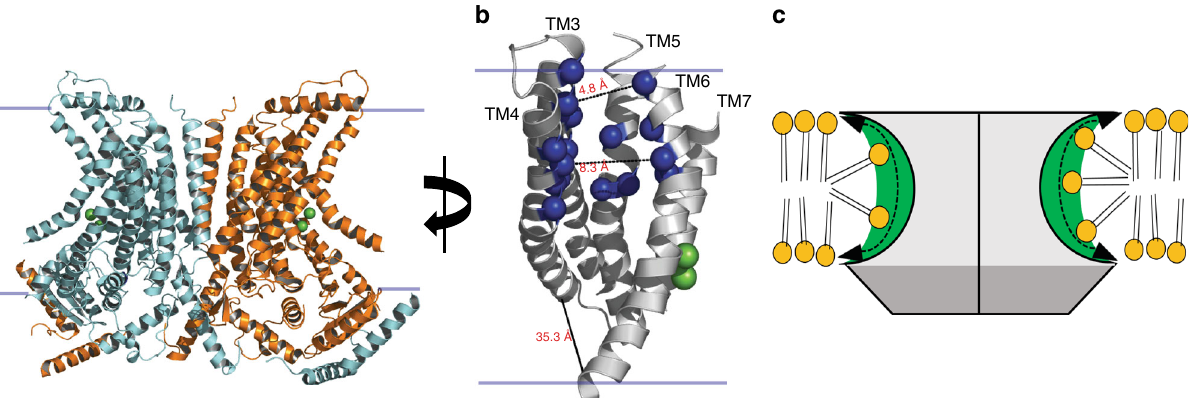
Fig. 1 Hydrophilic cavity and lipid scrambling of nhTMEM16. a The structure of nhTMEM16 viewed from the plane of the membrane. The two monomers are respectively colored in cyan and gold. Green spheres indicated the bound Ca 2 + ions. Solid lines denote the planes of the membrane. b Close up view of the hydrophilic cavity of nhTMEM16. The C α atoms of the residues mutated to tryptophan are shown as blue spheres and the bound Ca 2 + ions are indicated as green spheres. Dashed gray lines indicate the distance between the side chains at the extracellular entry (E313/R432), the mid-point and (T333/Y439) at the intracellular vestibule (A356/F463) of the groove. c Schematic representation of the credit-card model of lipid